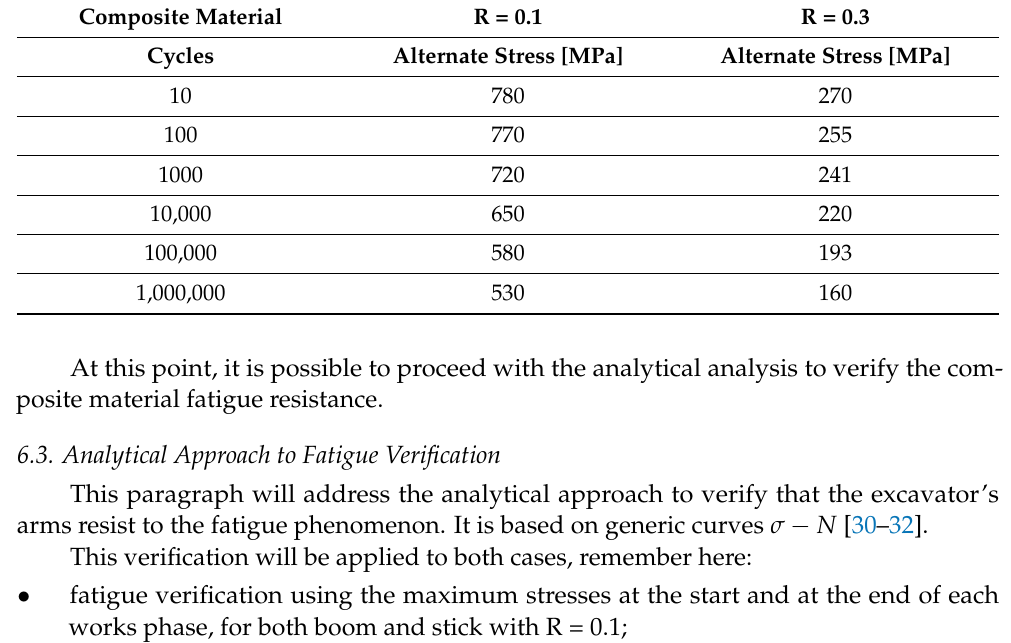
Table 7. Cycles–Alternate Stress with R = 0.1 for composite material chosen. Composite Material R =